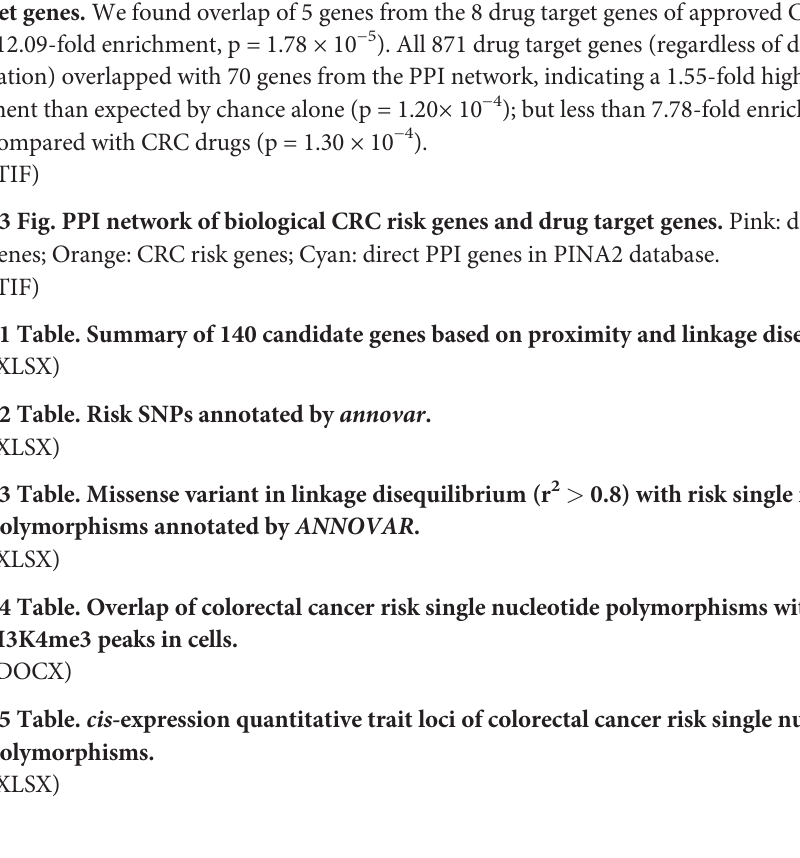
S1 Fig. Histogram distribution of gene scores. Thirty-five genes with a score of > 2 were de- fined as ‘ biological risk genes ’ . (TIF) S2 Fig. Overlap of 31 biological genes plus 553 genes in direct PPI with them and drug tar- get genes. We found overlap of 5 genes from the 8 drug target genes of approved CRC drugs (12.09-fold enrichment, p = 1.78 × 10 − 5 ). All 871 drug target genes (regardless of disease indi- cation) overlapped with 70 genes from the PPI network, indicating a 1.55-fold higher enrich- ment than expected by chance alone (p = 1.20× 10 − 4 ); but less than 7.78-fold enrichment compared with CRC drugs (p = 1.30 × 10 − 4 ). S3 Fig. PPI network of biological CRC risk genes and drug target genes. Pink: drug target genes; Orange: CRC risk genes; Cyan: direct PPI genes in PINA2 database. S1 Table. Summary of 140 candidate genes based on proximity and linkage disequilibrium. (XLSX) S2 Table. Risk SNPs annotated by annovar . (XLSX) S3 Table. Missense variant in linkage disequilibrium (r 2 > 0.8) with risk single nucleotide polymorphisms annotated by ANNOVAR . S4 Table. Overlap of colorectal cancer risk single nucleotide polymorphisms with H3K4me3 peaks in cells. S5 Table. cis -expression quantitative trait loci of colorectal cancer risk single nucleotide